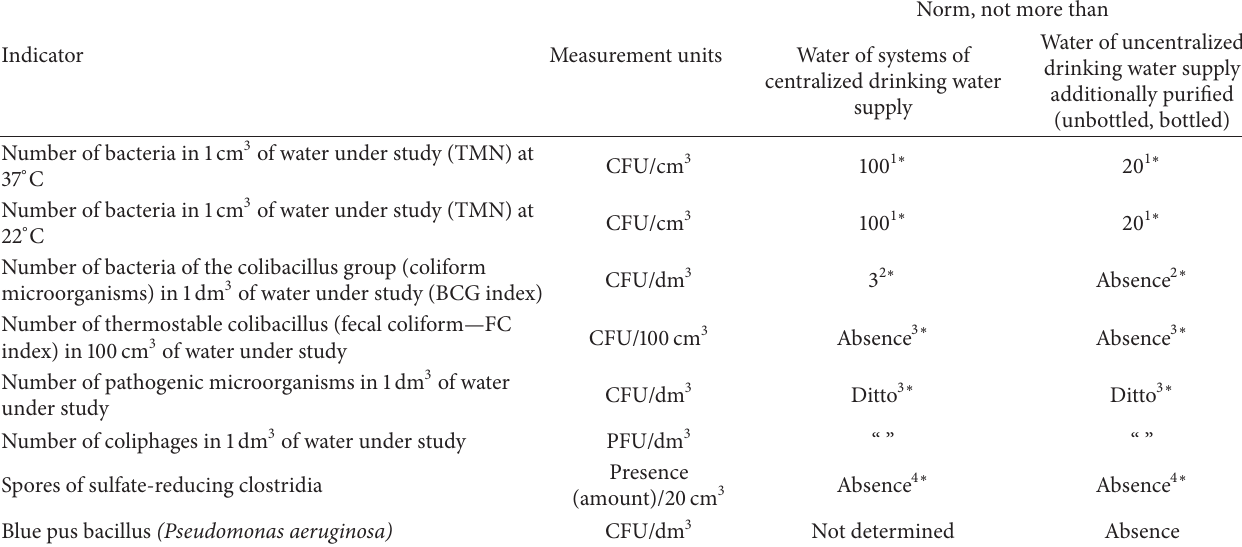
Table 1: Microbiological indicators of drinking water quality.